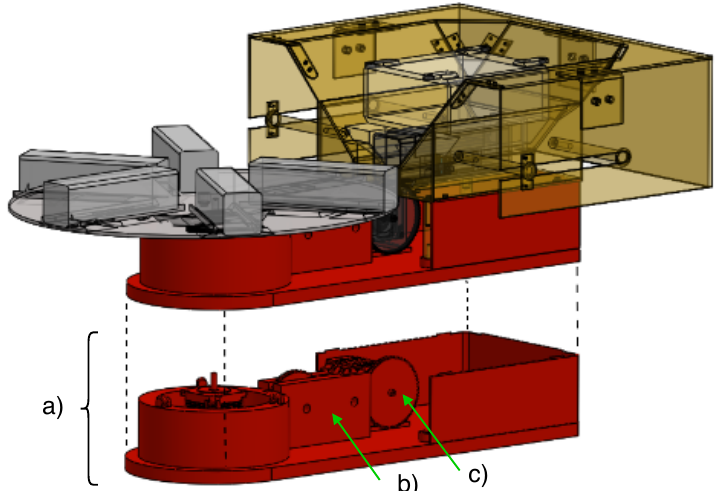
Figure 3. Battery swapping mechanism design: ( a ) rack, ( b ) coupling gear, and ( c )